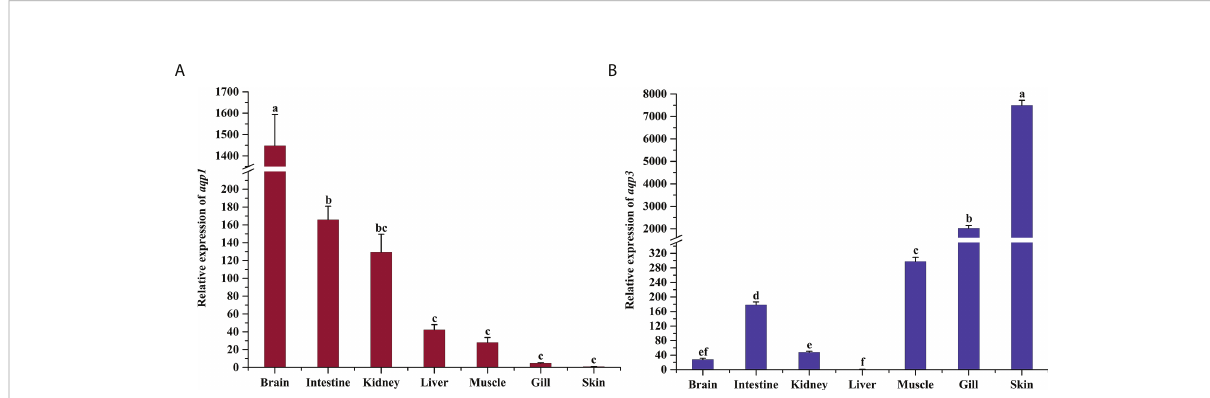
FIGURE 1 Tissue distribution and basal expression analysis of aqp1 (A) and aqp3 (B) in P. dabryanus . The different lowercase letters indicate signi fi cant differences among the different tissues. The bars represent the mean ± S.E.